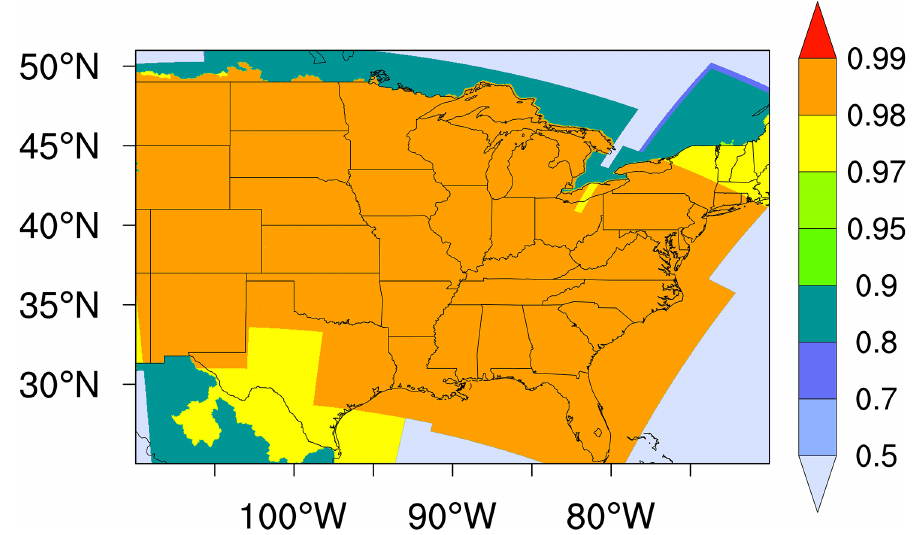
Figure A10. Distribution of the fraction of valid Stage IV precipitation data for 2004–2017. Here, “valid” means that precipitation data are available and reasonable. The erroneous precipitation discussed in Sect. 4.1 is unreasonable and